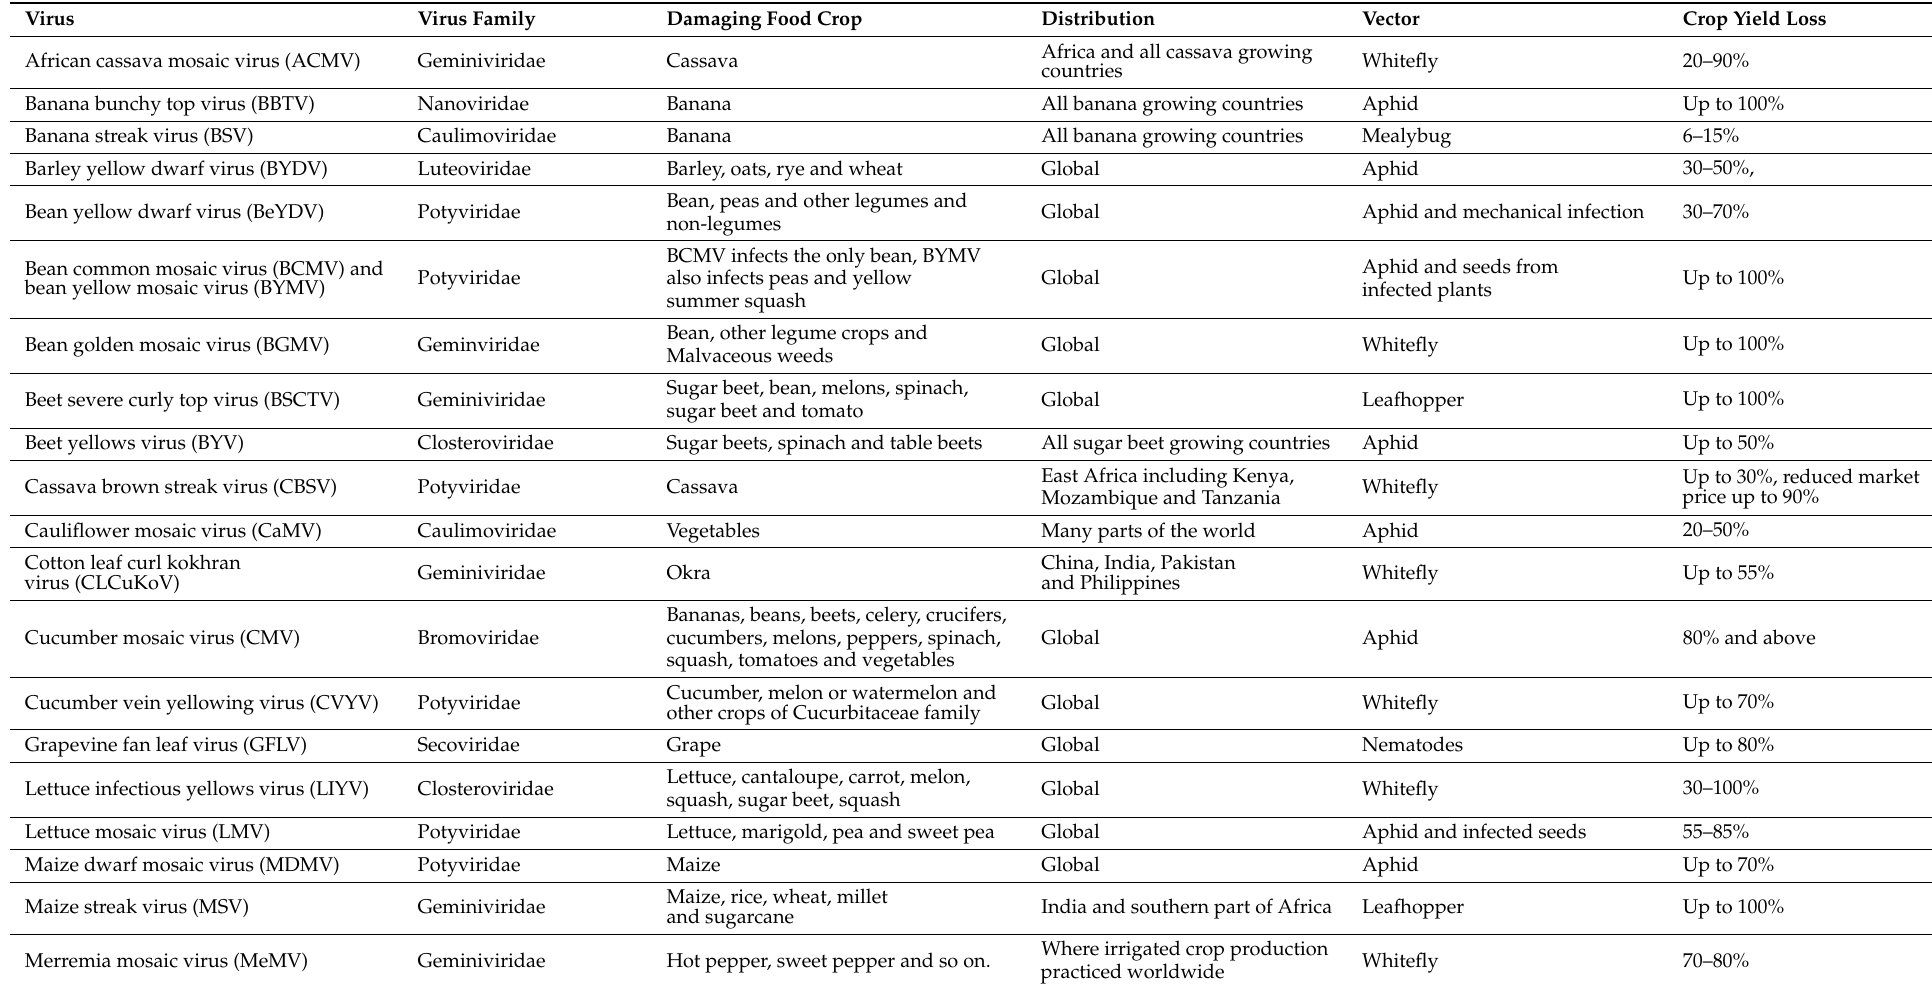
Table 1. A list of viruses causing diseases in food crops via insect vectors and estimated yield loss in different regions of the world; results summarized from G. N. Agrios (2005)